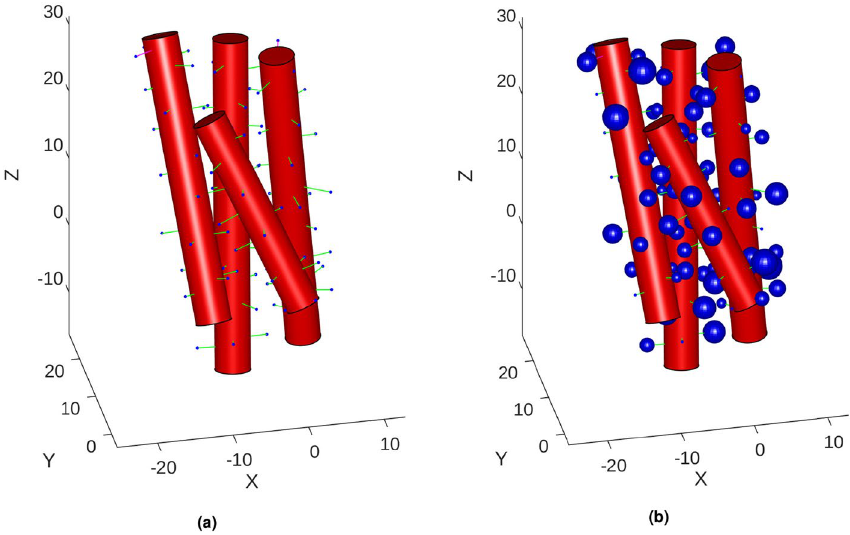
Figure 1. Visualisation of the R8 sub-domain’s alpha-helix objects within the simulation. The relative positioning and rotations were determined from the source .pdb file. Each blue dot ( a ) or blue sphere ( b ) represents a single sidechain position, the size of the blue spheres represent the approximated size of the sidechain and the green lines show the perpendicular direction to the backbone axis. The units of distance are Angstroms. For 3D Visualisation, see supplementary material. (MATLAB, 2020b, https:// www. mathw orks.